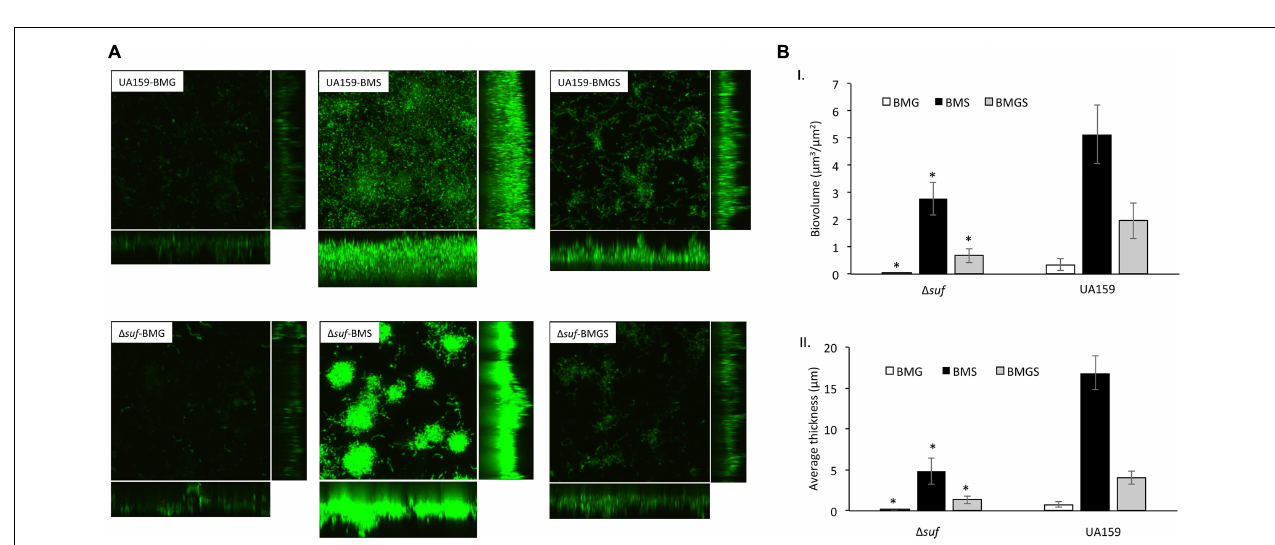
FIGURE 5 | Analysis of biofilm formation on 96-well plates. Streptococcus mutans wildtype, UA159 and the (cid:49) suf::kan r mutant ( (cid:49) suf ) were grown in BM medium with glucose (BMG), sucrose (BMS), and glucose plus sucrose (BMGS), and biofilms on the polystyrene plates were analyzed using a spectrophotometer. Data represented here are means ( ± standard deviation) of at least three independent experiments, with ∗ indicating significant differences at P < 0.05.